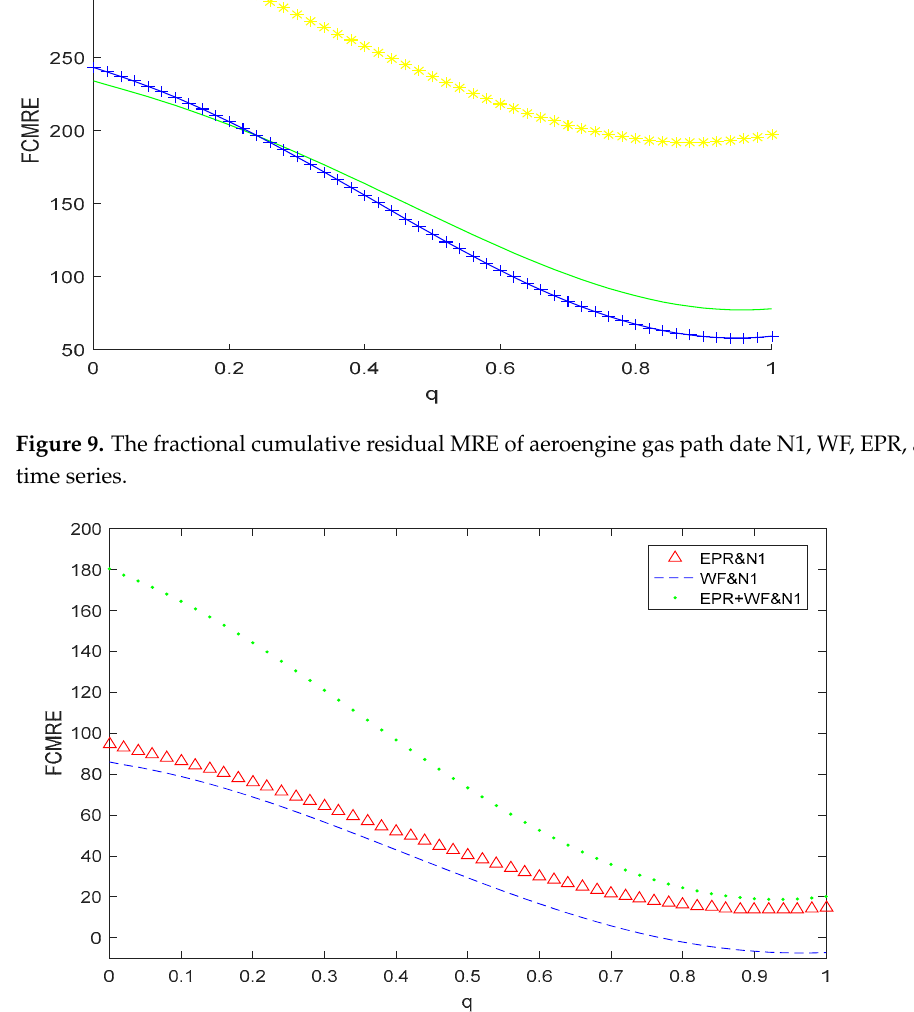
Figure 10. The fractional cumulative residual MRE of EPR, WF, EPR + WF, and N1 time series. At the same time, like the relative entropy, FCMRE can also reflect the difference between different information. After the q value is determined, In Figure 9, the longitudinal comparison shows that the FCMRE value between engine pressure ratio (EPR) and high- pressure rotor speed (N1) is much larger than that between fuel flow (WF) and high-pressure rotor speed (N1) and that between exhaust gas temperature (EGT) and engine pressure ratio (EPR), which indicates that the information difference between fuel flow (WF) and high-pressure rotor speed (N1), exhaust gas temperature (EGT) and engine pressure ratio (EPR) is much smaller than the FCMRE value between engine pressure ratio (EPR) and high-pressure rotor speed (N1). It also reflects that the information correlation between fuel flow (WF) and high-pressure rotor speed (N1), exhaust gas temperature (EGT), and engine pressure ratio (EPR) is